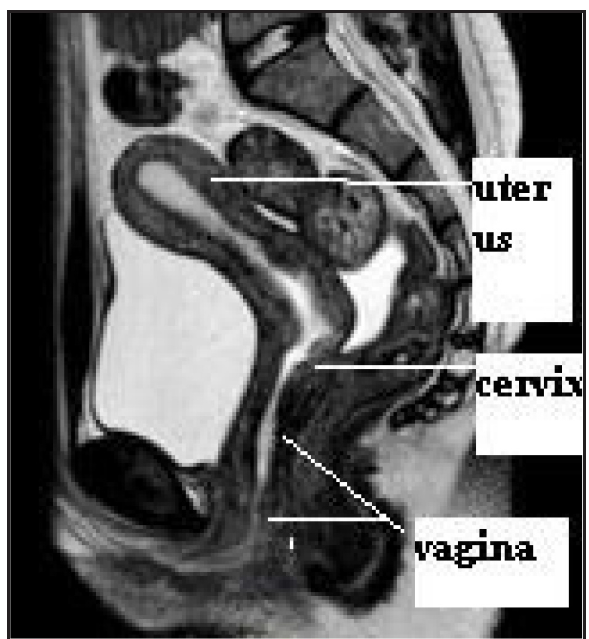
Figure 3. After Second Surgery MRI film: Normal uterus and normally formed cervix, and